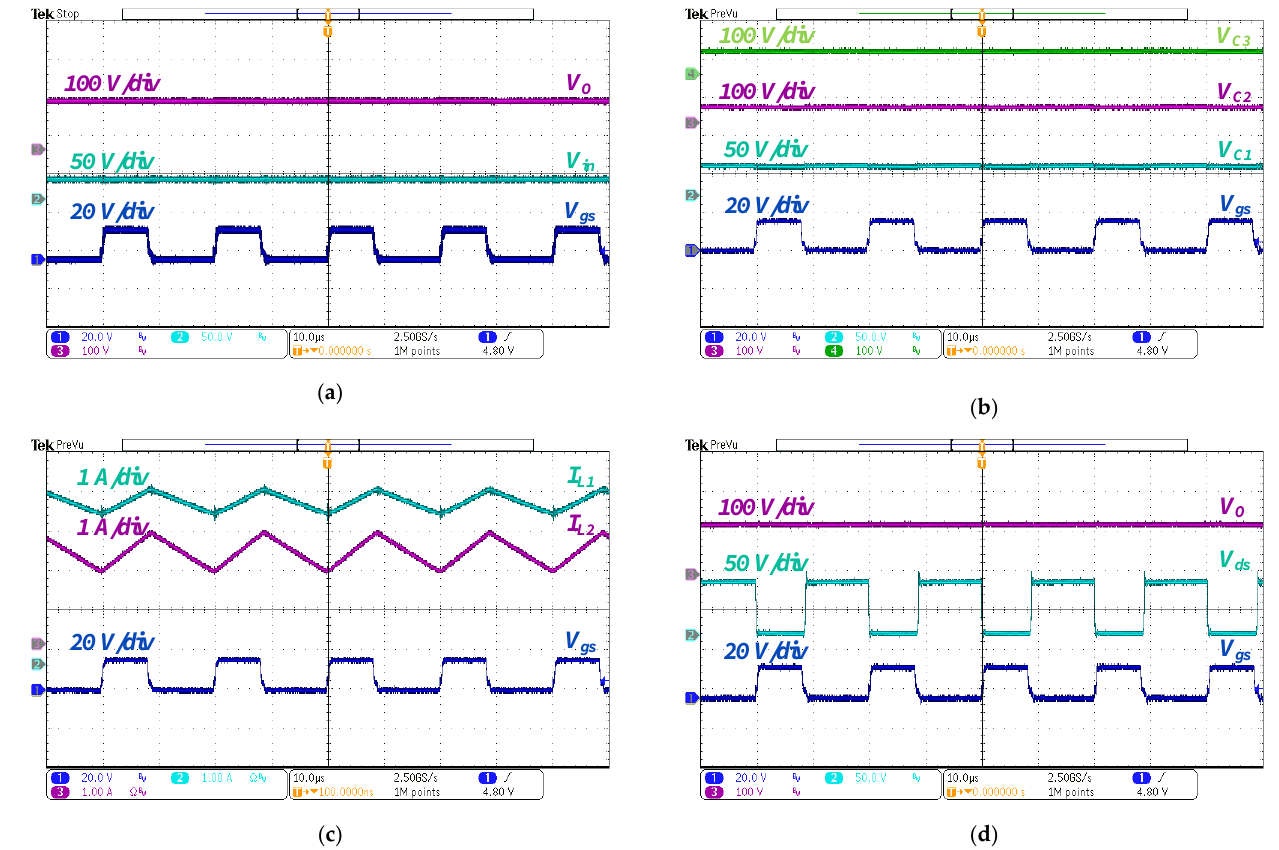
Figure 16. Related waveforms of the experimental results for proposed converter I. ( a ) Gating pulse, input voltage, and output voltage; ( b ) gating pulse, voltage for capacitor C 1 , C 2 , and C 3 ; ( c ) gating pulse, inductor current for L 1 and L 2 ; and ( d ) gating pulse, switch voltage, and output voltage.